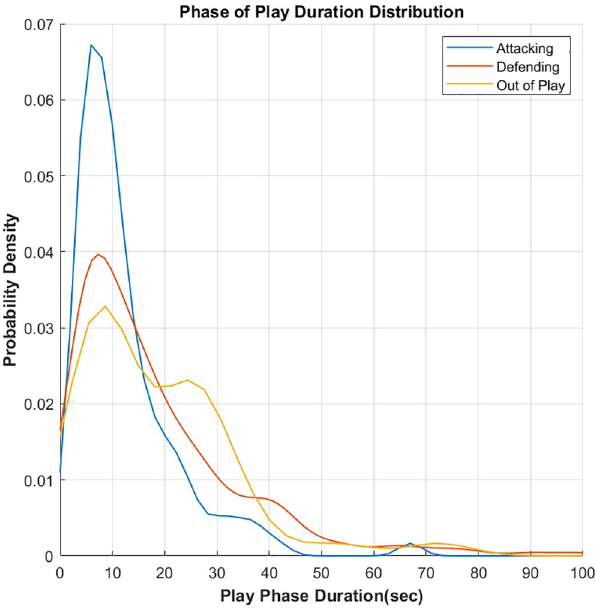
Fig 2. The distribution of the duration individual segments of play (i.e. ‘plays’) in each phase (Attacking, defending and out-of-play) across both games.